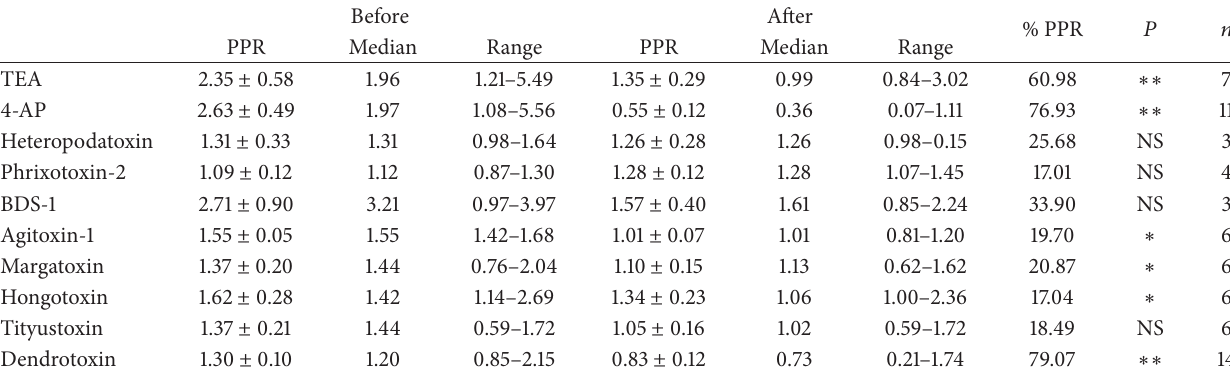
Table 1: Effects of K V channels blockers on PPR. Statistical